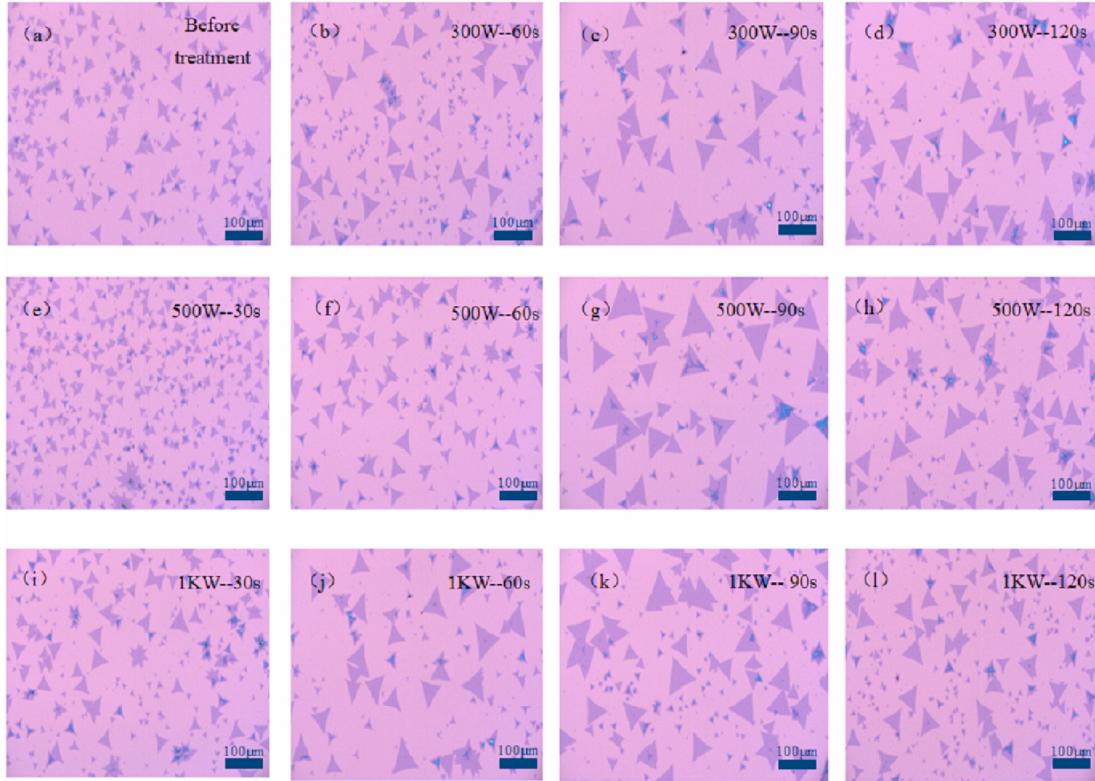
Figure 2. The growth of MoS 2 on SiO 2 /Si substrate under the different oxygen plasma treatment time and power. ( a ) Before treatment, ( b ) 300 W, 60 s, ( c ) 300 W, 90 s, ( d ) 300 W, 120 s, ( e ) 500 W, 30 s, ( f ) 500 W, 60 s, ( g ) 500 W, 90 s, ( h ) 500 W, 120 s, ( i ) 1 KW, 30 s, ( j ) 1 KW, 60 s, ( k ) 1 KW, 90 s, ( l ) 1 KW, 120